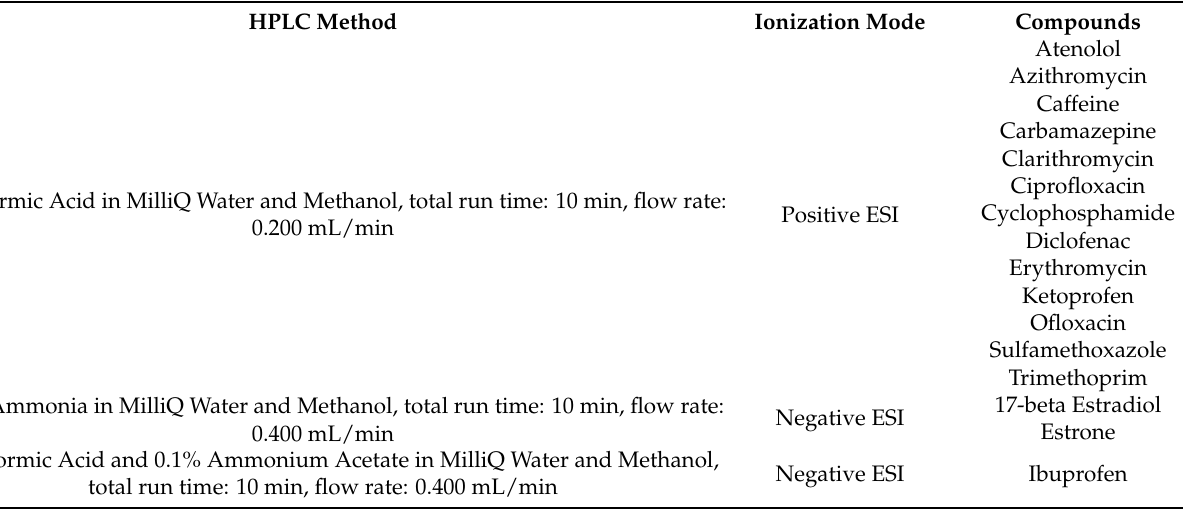
Table A2. Analysis parameters for the 16 target